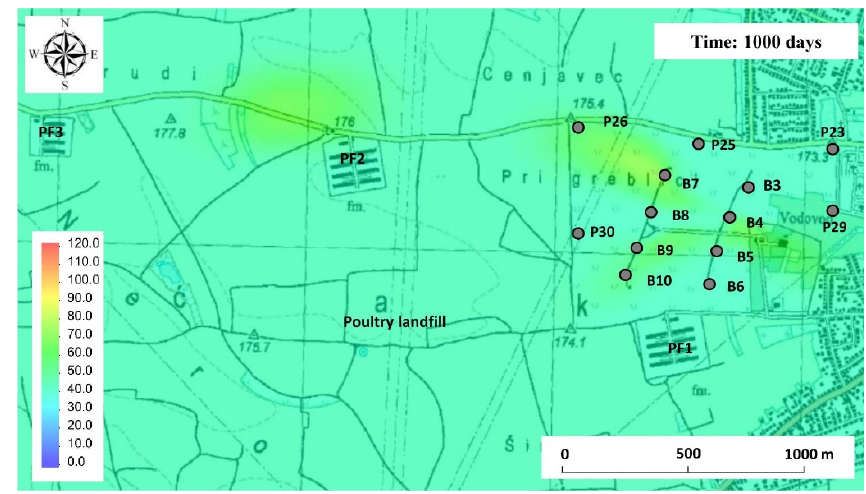
Figure 9. Nitrate pollution propagation by impulse initial conditions—1000 days.